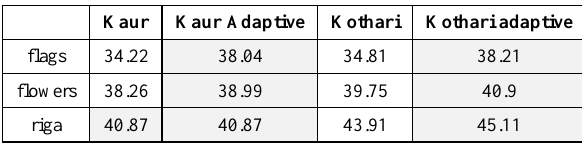
Fig. 7. Examples of attacks performed (Kaur adaptive method